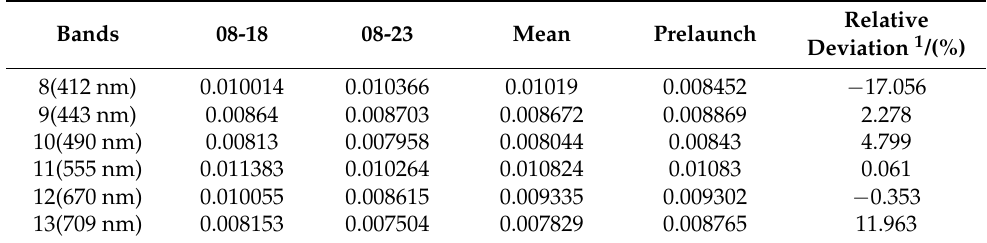
Table 3. Calibration coefficients of FY-3D/MERSI-II at the Lake Qinghai RCS.